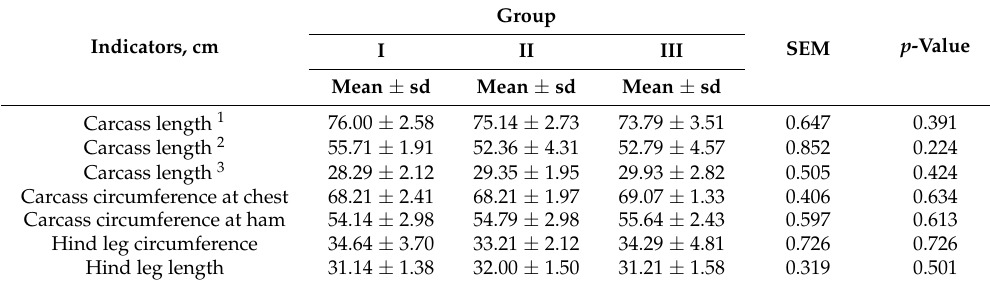
Table 4. Measures of lamb carcass